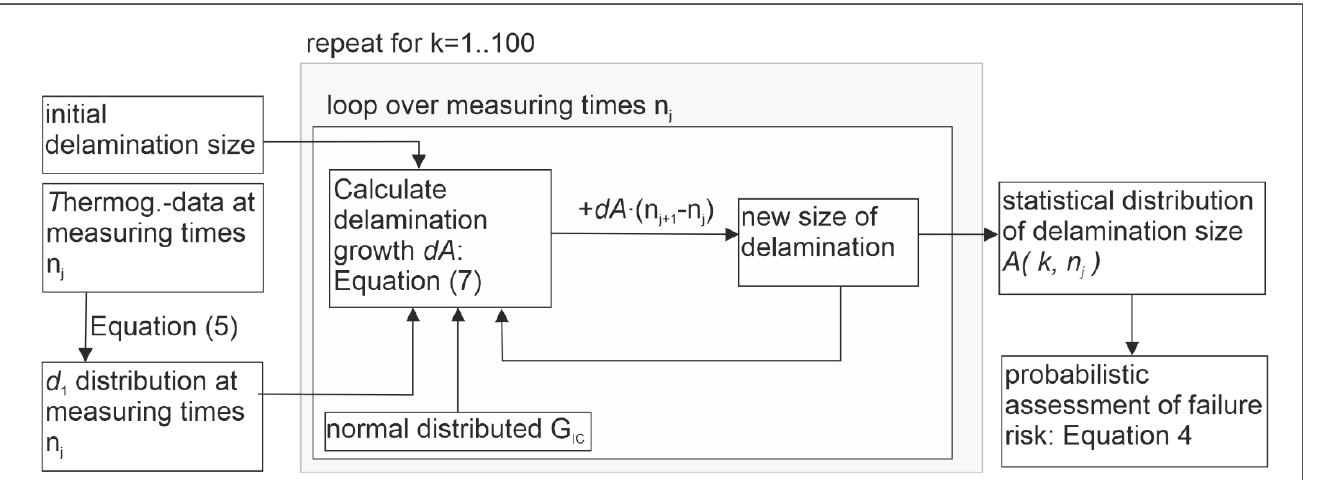
Figure 8. ( a ) Numerically calculated solution space of equation 5.7 for paired values c , z , resulting in the least Error Y , ( b ) 20-bin histogram of z -values and ( c ) histogram of c -values for z lying within the most probable bin ( z > 4.77).